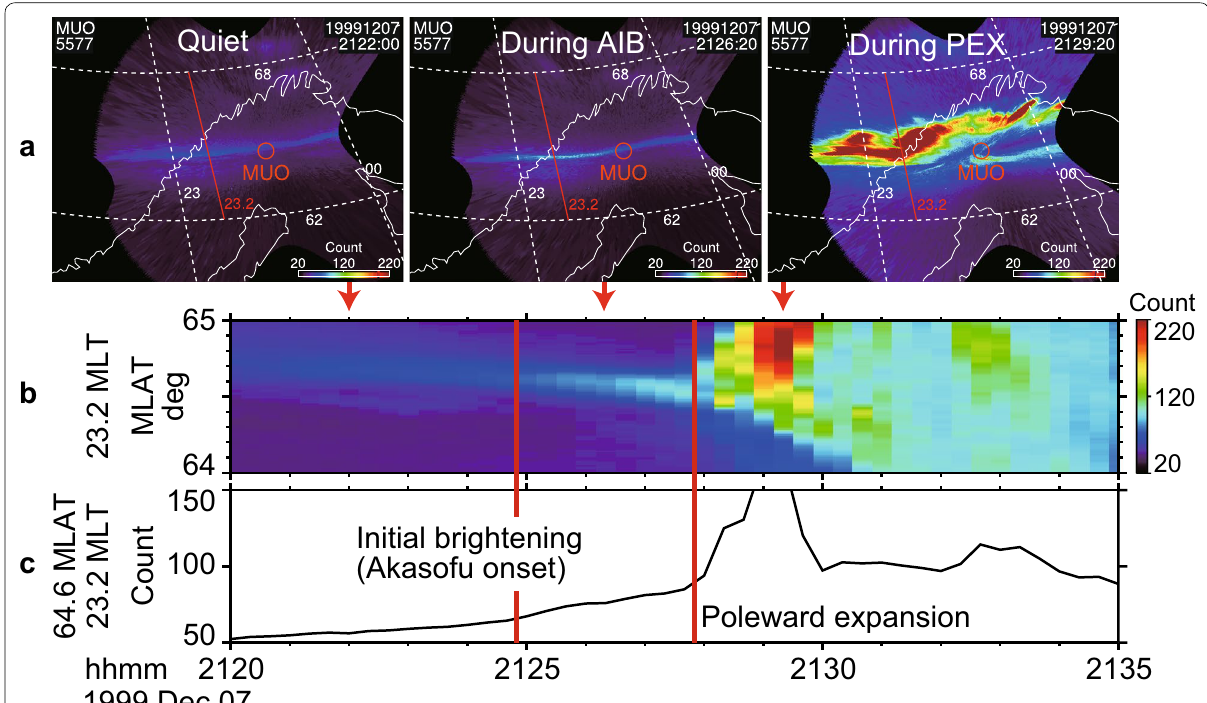
Fig. 5 Ground‑based all‑sky images (ASIs) near the substorm onset location on December 7, 1999. Auroral brightness at a wavelength of 557.7 nm (green line) observed at Muonio (MUO) in Finland is shown. a Selected images represent three intervals as labeled, shown in the geodetic coordinates. The white reference lines represent MLTs and MLATs. The red line indicates 23.2 MLT, the approximate location of the initiation of the Akasofu initial brightening (AIB) and the poleward expansion. b Auroral keograms sliced along the onset meridian (23.2 MLT, which correspond to the red lines in a . c Time series of auroral brightness near the onset location (23.2 MLT, 64.6 MLAT) averaged over 23.0–23.4 MLT and 64.5–64.7 MLAT. The red vertical lines in b and c indicate the times of the AIB (2124:50 UT) and the poleward expansion (2127:50 UT) in